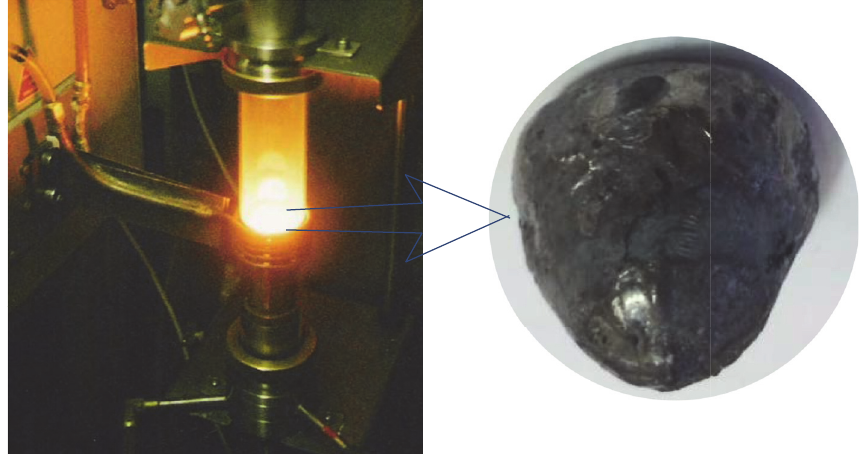
Figure 2: The hottest part of the High Frequency Induction furnace during the melting before solidification; view of an obtained